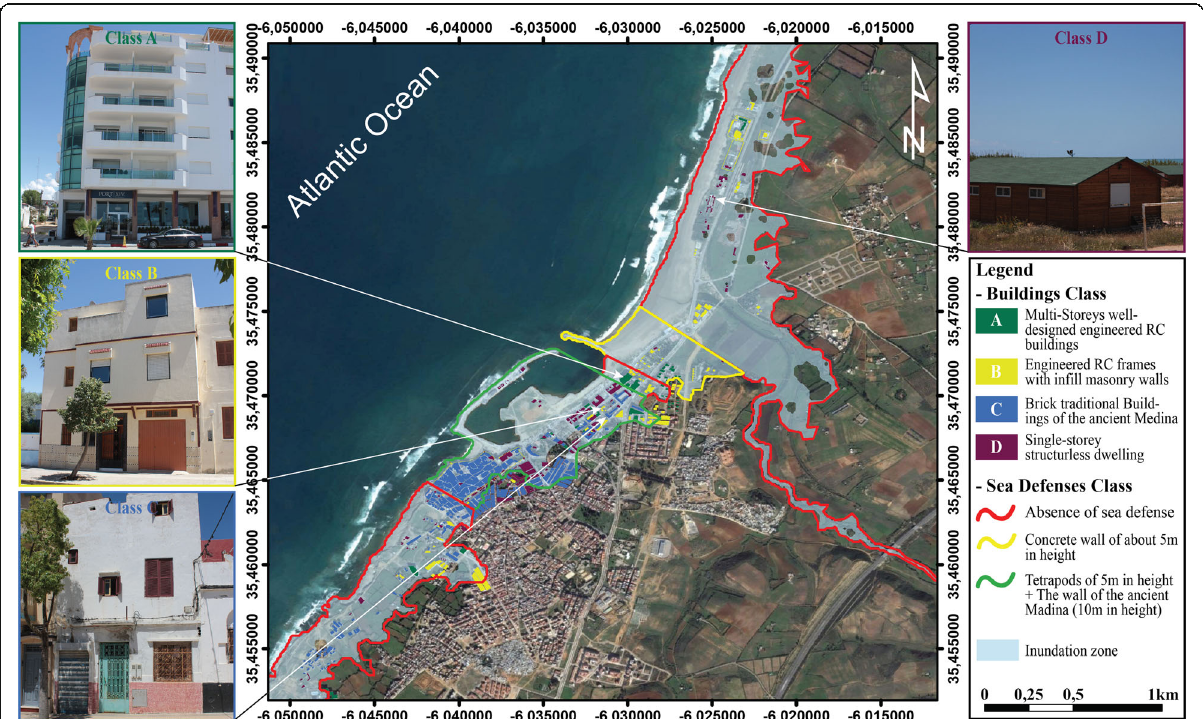
Fig. 3 Map displaying buildings classes (A: multi-storeys well-designed engineered RC buildings, B: non-engineered RC building with masonry infill walls, C: non-engineered timber construction, brick traditional buildings of the Old Town, D: Single-storey structureless dwelling), and sea-defense classes identified during the field survey in Asilah-Morocco